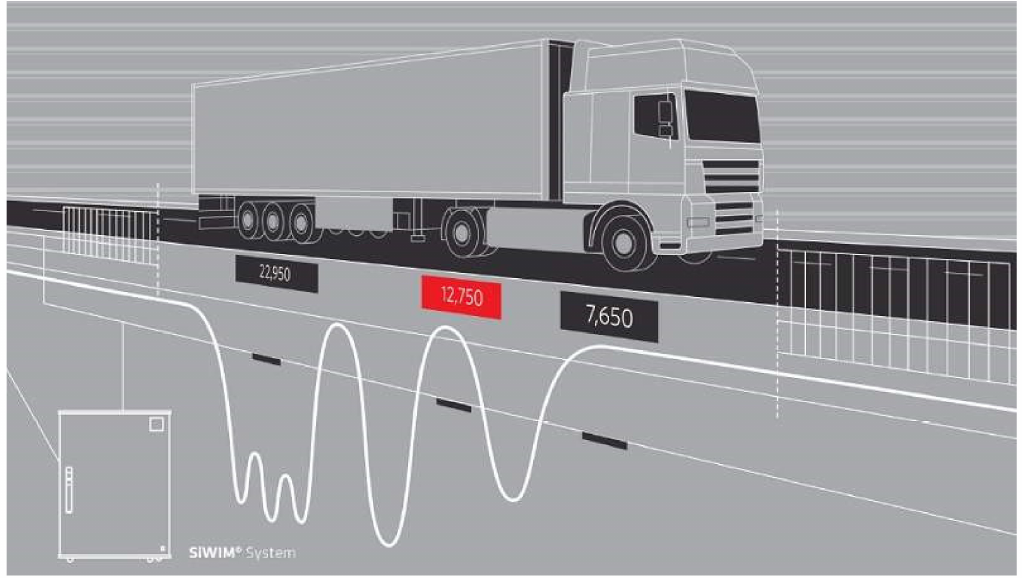
Figure 5. Simplified measurement scheme